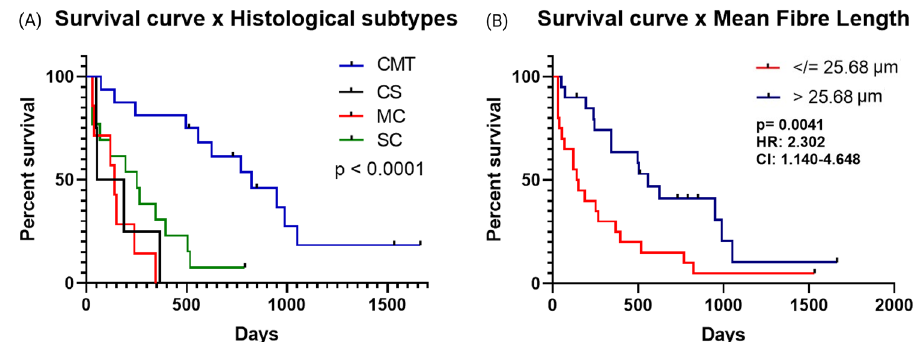
Figure 5. ( A ) Survival curves for dogs presenting the histological subtypes, CMT carcinoma in mixed tumour, CS carcinosarcoma, MC micropapillary carcinoma, SC solid carcinoma. ( B ) Survival curves separating the cases by the collagen mean fibre length, the red line for fibre length ≤ 25.68 µ m and the blue line for fibre length > 25.68 µ